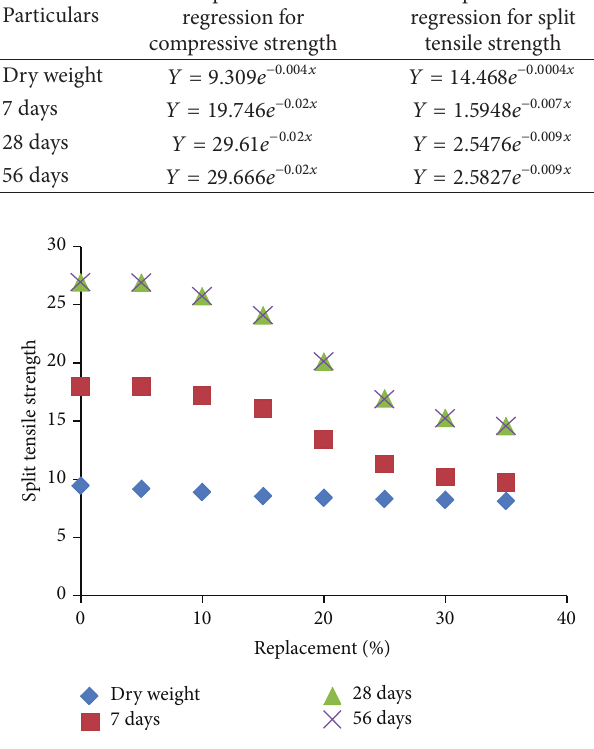
Figure 6: Exponential graph for split tensile strength and dry weight. Table 3: Flexural strength of beam.